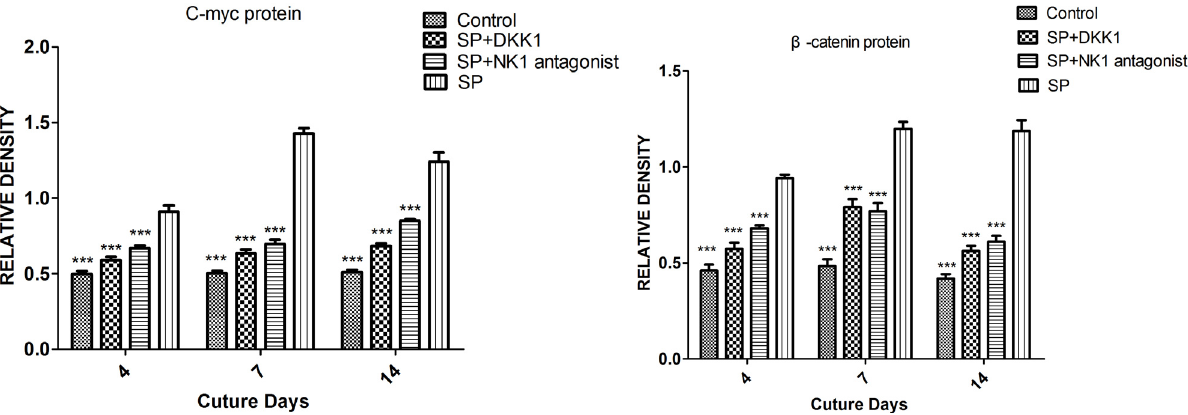
Figure 5. Effects of SP, SP + NK1 antagonist, SP + DKK1 and the same amount of PBS on days 4, 7, and 14 on β -catenin protein and c-myc protein expressions in MC3T3-E1 cells measured by Western blot analysis. *** p < 0.001 versus